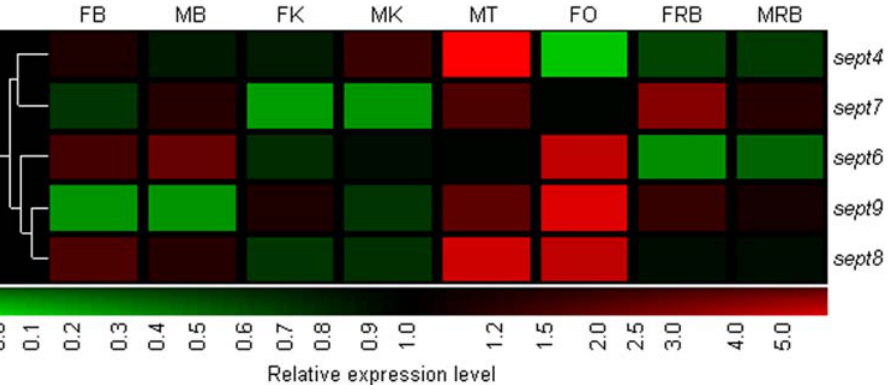
Figure 3. Hierarchical clustering of expression profiles of five members of the septin gene family in zebrafish. Expression patterns of sept6 , sept9 and sept8 appeared to be highly correlated to each other while sept4 and sept7 formed a separate cluster. sept4, sept6 , sept9 and sept8 were most strongly expressed in either one or both gonads. sept7 had highest expression in the female ‘rest-of-body’ but strong expression was also observed in the testis. Refer to Fig. 2 for